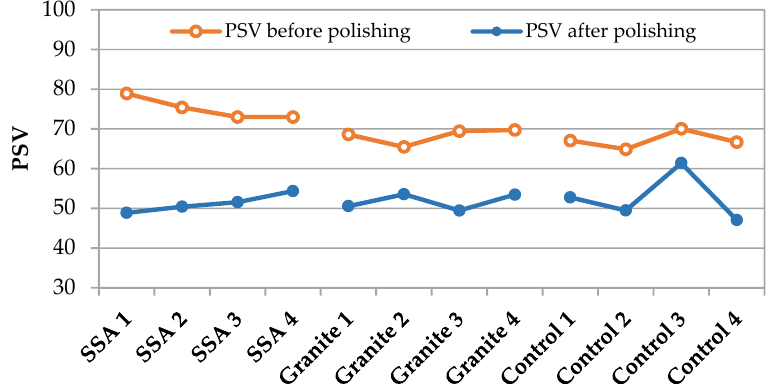
Figure 3. PSV results were obtained before and after the accelerated polishing test.